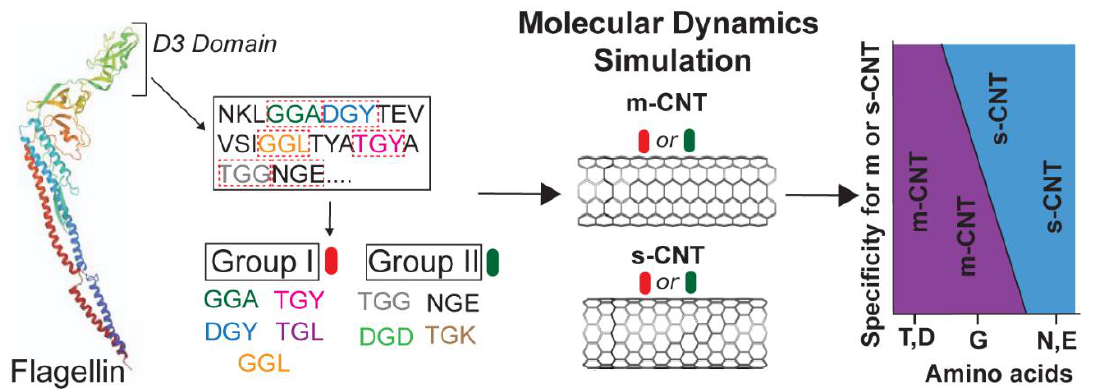
Figure 1. The tripeptide library modelled from the D3 domain of flagellin is composed of nine tripeptides as shown. Each tripeptide has a middle glycine (outlined) as a common denominator